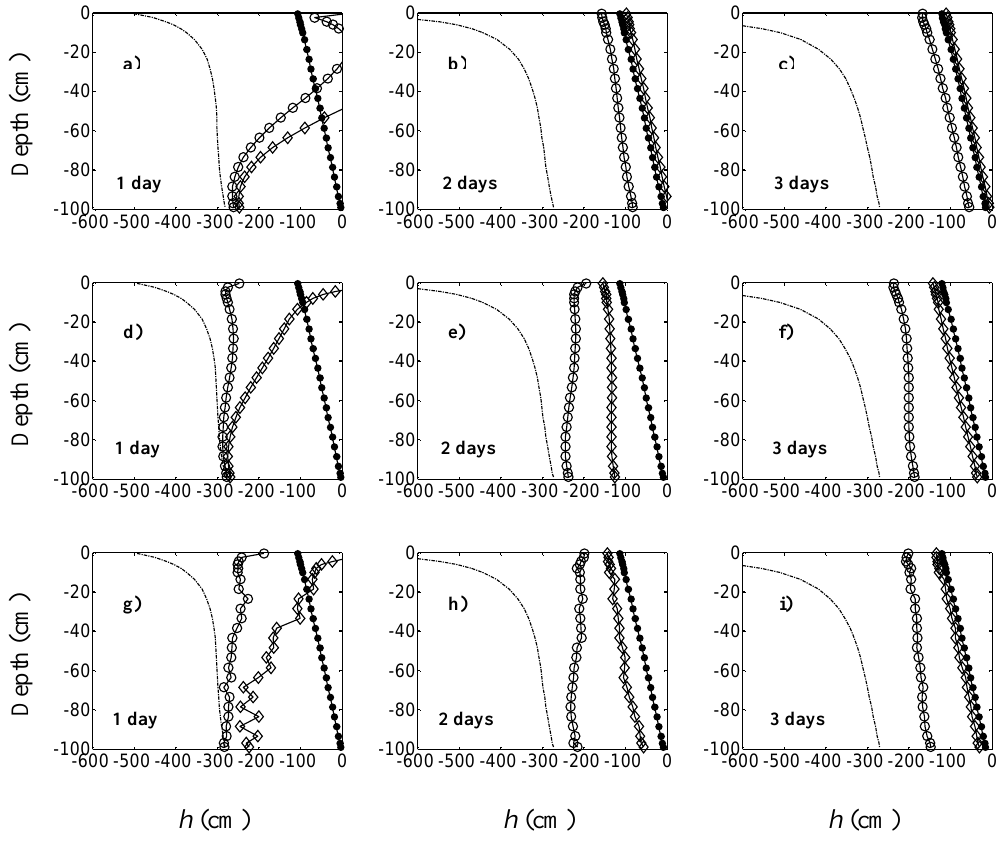
Figure 5. Retrieved profiles by assimilating daily observations of soil moisture contents involving nodes within the top 0.5cm (open circle) and 10.5cm (diamond) compared with the “true” profile (closed circle) and “guess” profile (dashed line), for different combinations of Kalman Filters and numerical schemes: (a–c) EKF-CN; (d–f) UKF-NL; (g–i) EnKF-NL.